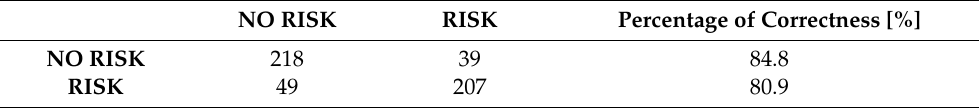
Table 10. Confusion Matrix of the Binary Logistic Regression Model.